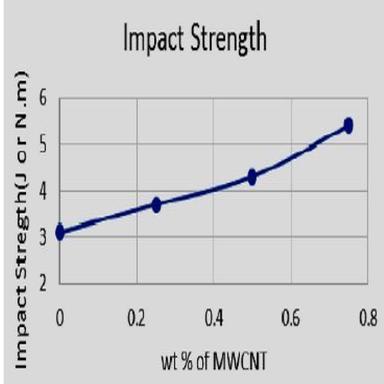
Variation of impact strength with wt % of MWCNT .